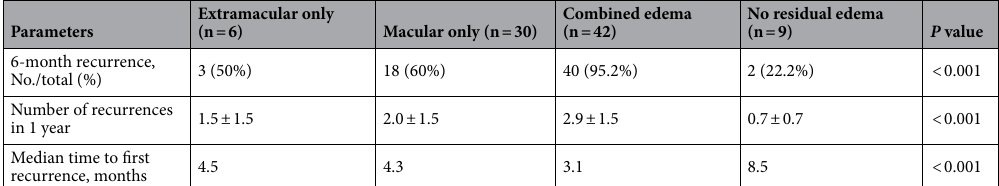
Table 2. Parameters of macular edema recurrence in groups of patients separated according to retinal edema pattern at 1 month after initial anti-vascular endothelial growth factor (VEGF) therapy (n = 87). Continuous values are denoted as mean ± standard